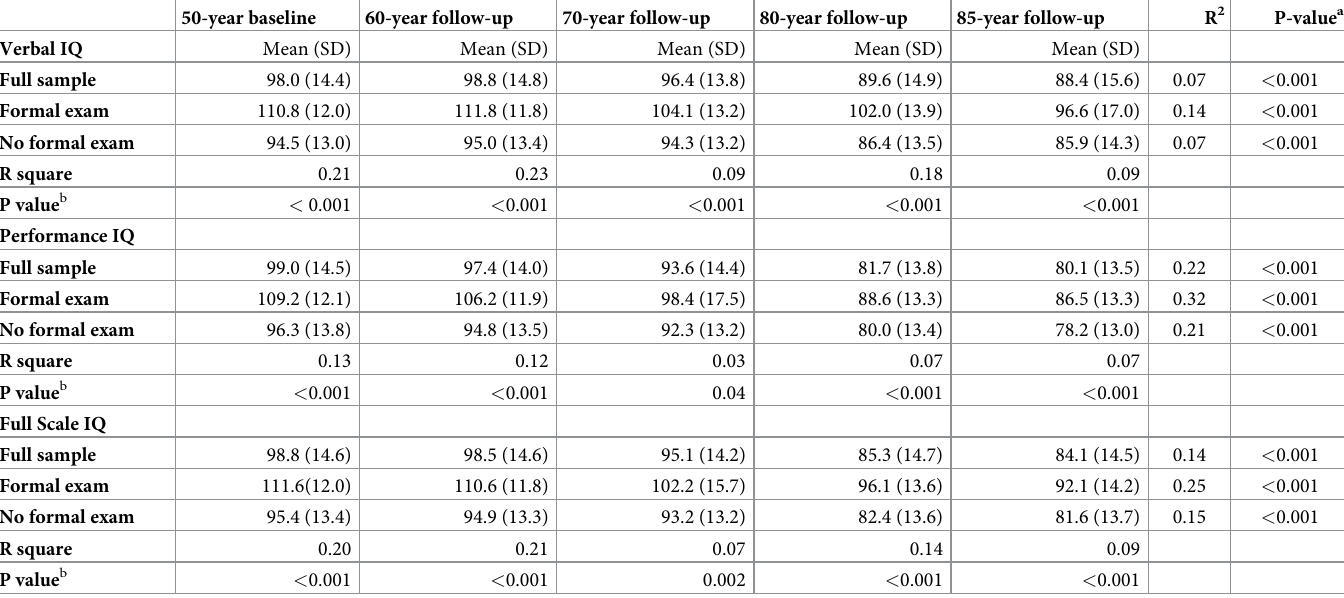
Table 2. Mean (SD) for Verbal-, Performance-, and Full Scale IQ stratified on